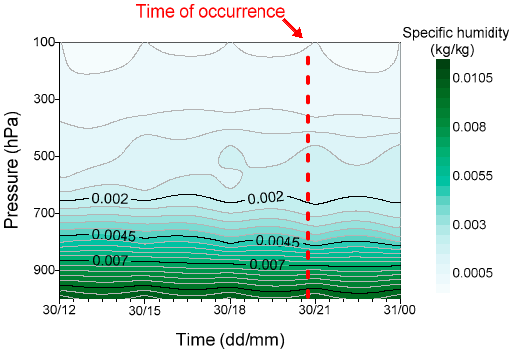
Figure 4. Specific humidity (kg/kg) between 12:00 UT on 30 July 2017 and 00:00 UT on 31 July 2017 for the center location of the case study downburst.